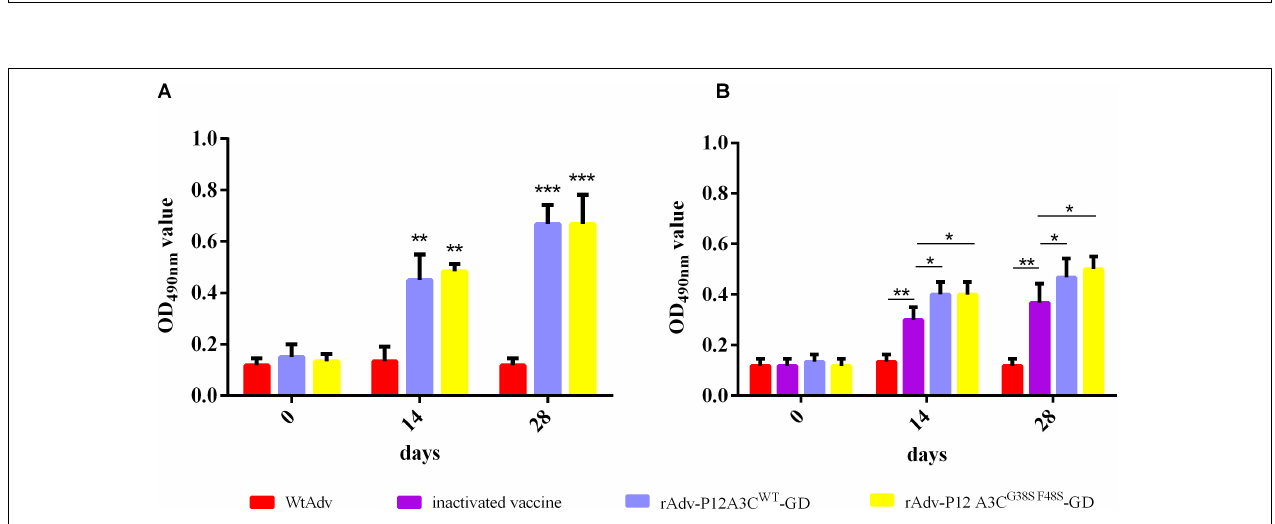
FIGURE 5 | Anti-FMDV IgA antibodies detected with indirect ELISA. (A) Anti-FMDV IgA antibodies in the nasal washes of the intraocular–nasally immunized mice were tested with indirect ELISA. (B) Anti-FMDV IgA antibodies in the nasal washes of the intramuscularly immunized mice were tested with indirect ELISA. Results are presented as means ± SD ( n =